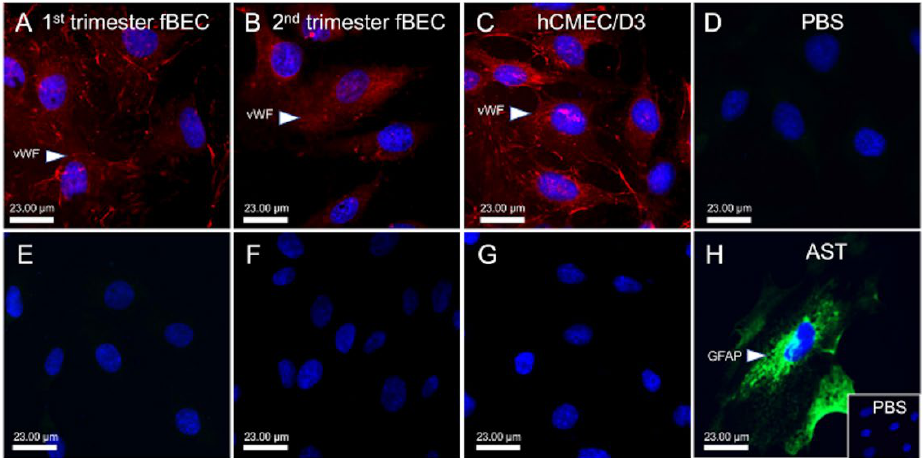
Figure 1. Expression of von Willebrand Factor (vWF) in early and mid-gestation cultured primary human fetal brain endothelial cells (hfBECs). ( A – C ) Representative immunofluorescence of the endothelial cell marker von Willebrand factor (vWF; red) identified the hfBECs in the early ( A ) and mid- ( B ) gestation and in the adult endothelial hCMEC/D3 cell line ( C ). ( A – H ) DAPI (blue; a nuclear marker). ( E – G ) Glial fibrillary acidic protein (GFAP; green—a glial cell marker) staining was absent in all hfBEC cultures. ( H ) GFAP positive staining was confirmed in primary human fetal brain astrocyte culture ( D ) PBS (negative control). n = 4/gestational age (representative images presented). Scale bar represents 23 μm.